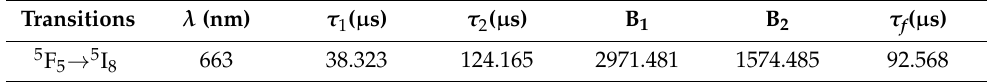
The fluorescence lifetime of 5 F 5 level were fitting to be 92.568 µ s. Then, the quantum efficiency ( η ) obtained by Equation